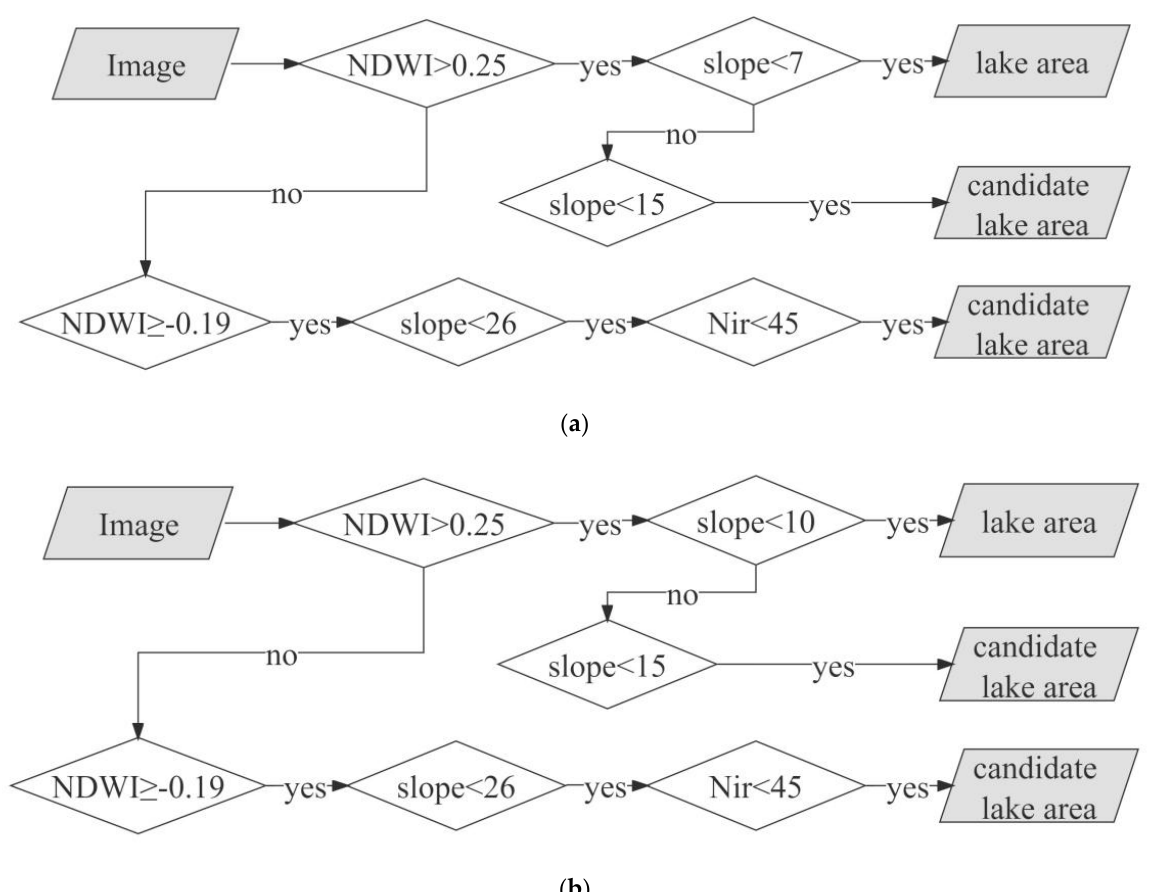
Figure 14. Feature rule sets: ( a ) one feature rule set in the comparison experiment; ( b ) another feature rule set in the comparison experiment.